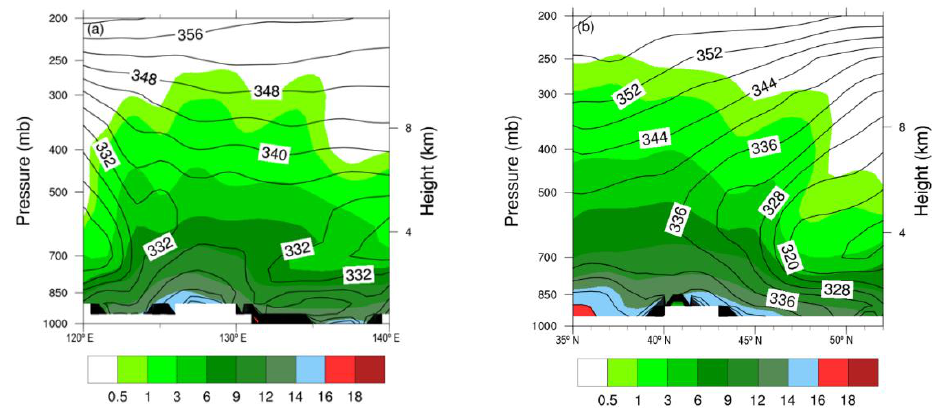
Figure 10. Vertical cross section of pseudo equivalent potential temperature (solid line; K) and specific humidity (shaded; g/kg) and along 42.5° N ( a ), and 126.5° E ( b ) at 19 UTC on 14 August 2019.